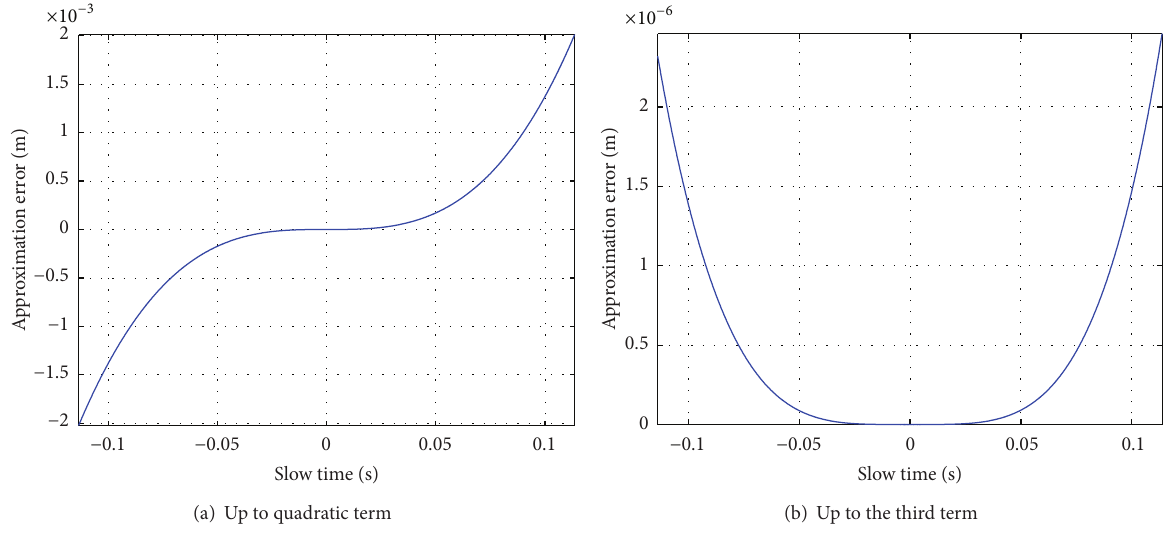
Figure 2: Approximation errors of the bistatic slant